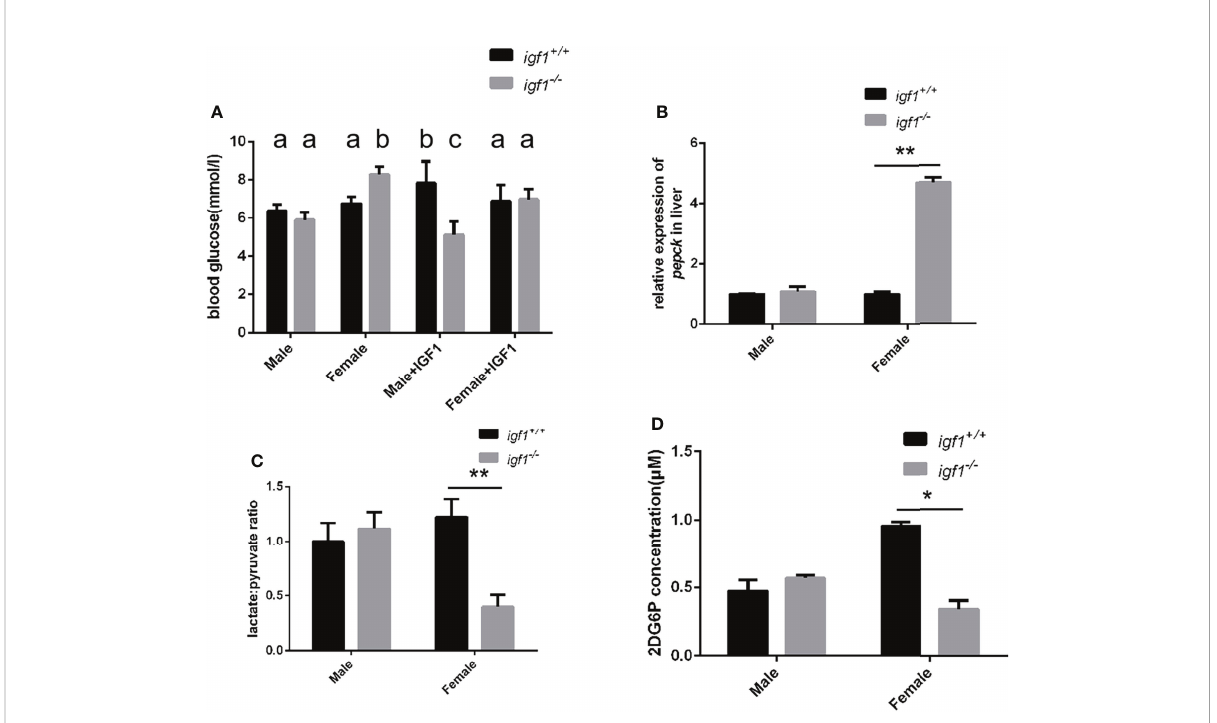
FIGURE 6 Alterations of glucose metabolism in igf1 -de fi cient fi sh. (A) Postprandial plasma glucose levels (1 h after each meal) of igf1 -de fi cient fi sh and sdminastration of recombinanat IGF1 protein(n = 6/group). The letters a, b and in the charts represent signi fi cant differences between which labeled with different letters. (B) Relative expression of pepck gene. (C) The hepatic lactate/pyruvate ratios of igf1 -de fi cient fi sh (n = 8/group). (D) The hepatic 2DG6P levels of igf1 -de fi cient fi sh. * P < 0.05; ** P <